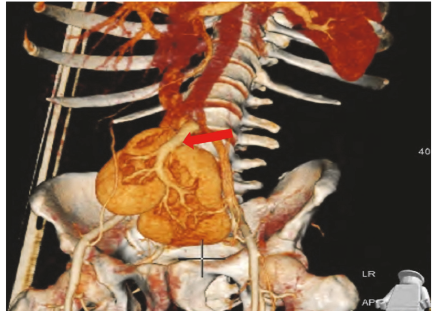
Figure 3: MDCT with VRT (volume rendering technique) showing the crossed unfused ectopic kidneys with the presence of joined draining vein (red arrow) of both